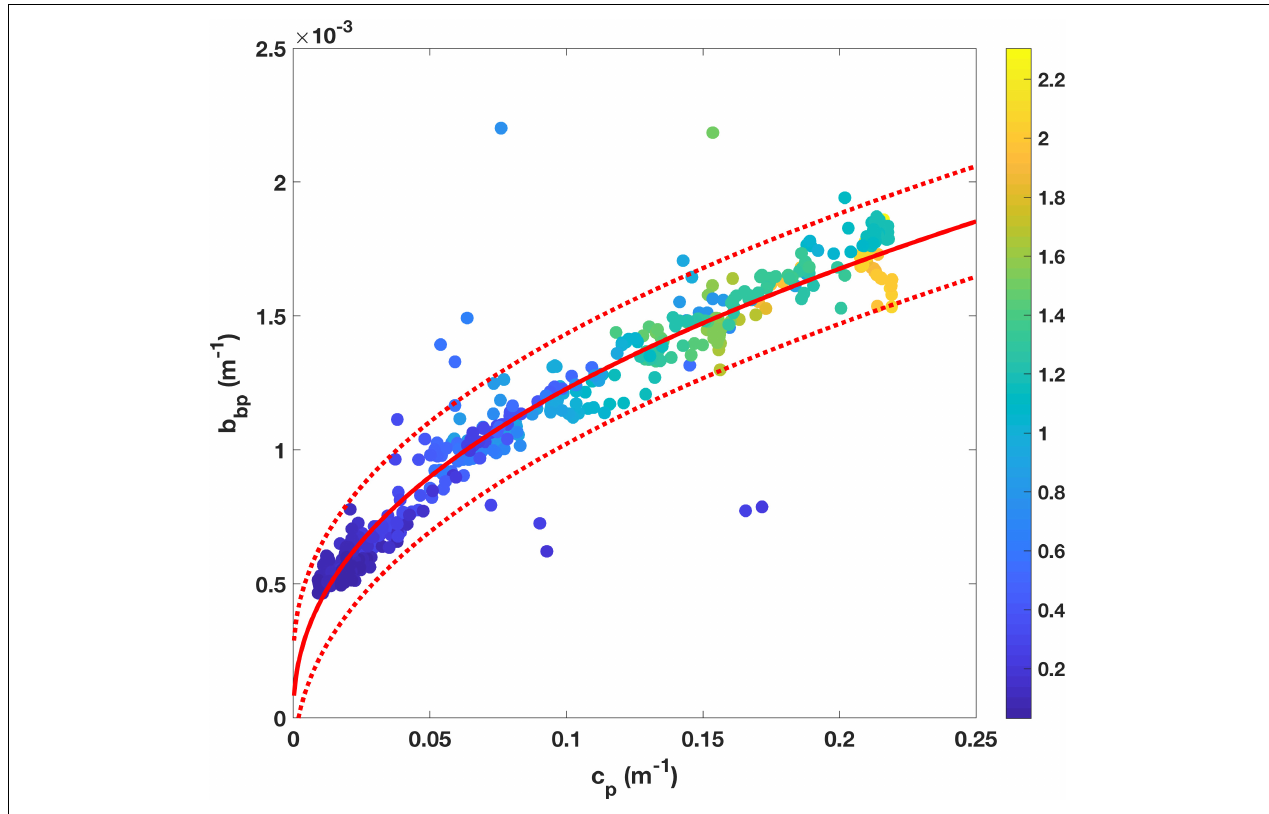
FIGURE 3 | Empirical relationship between particulate beam attenuation, c p , and particulate backscatter, b bp , observed during SOTS 2018 voyage, with power fit (red line) and 95% confidence limits (red dashed line). Individual points are color-coded based on corresponding fluorescence measurements (nominal